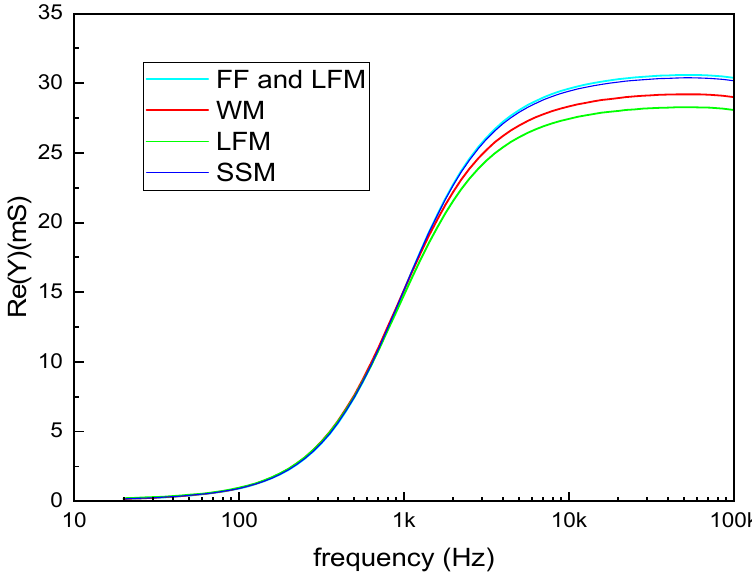
Figure 6. Real part of the admittance, that is the conductance, of the same milk samples of Figure 4. Although the admittance measurement is a very interesting method for the character- ization of milk whose composition is known, it could fail as a blind detection technique.